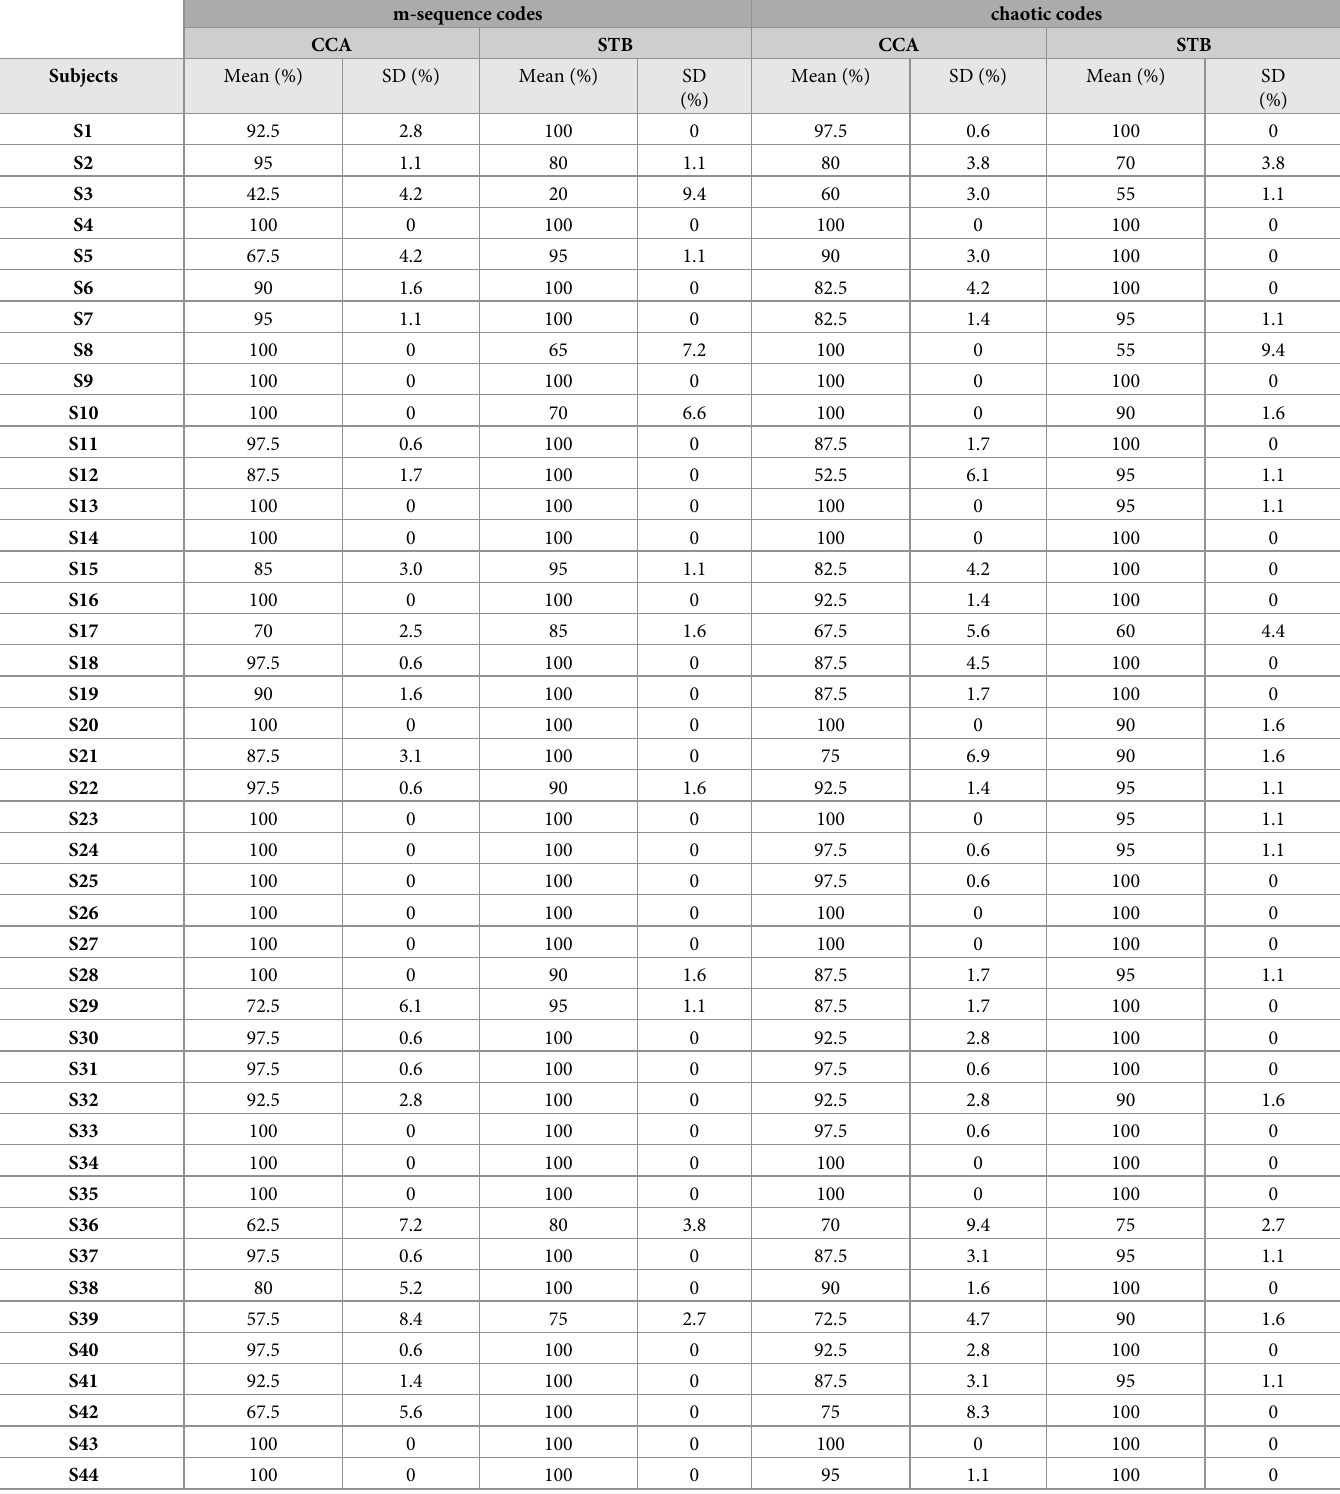
Table 2. Accuracies of target identification results of the 10-fold cross-validation for a trial for m-sequence and chaotic code for all subjects. m-sequence